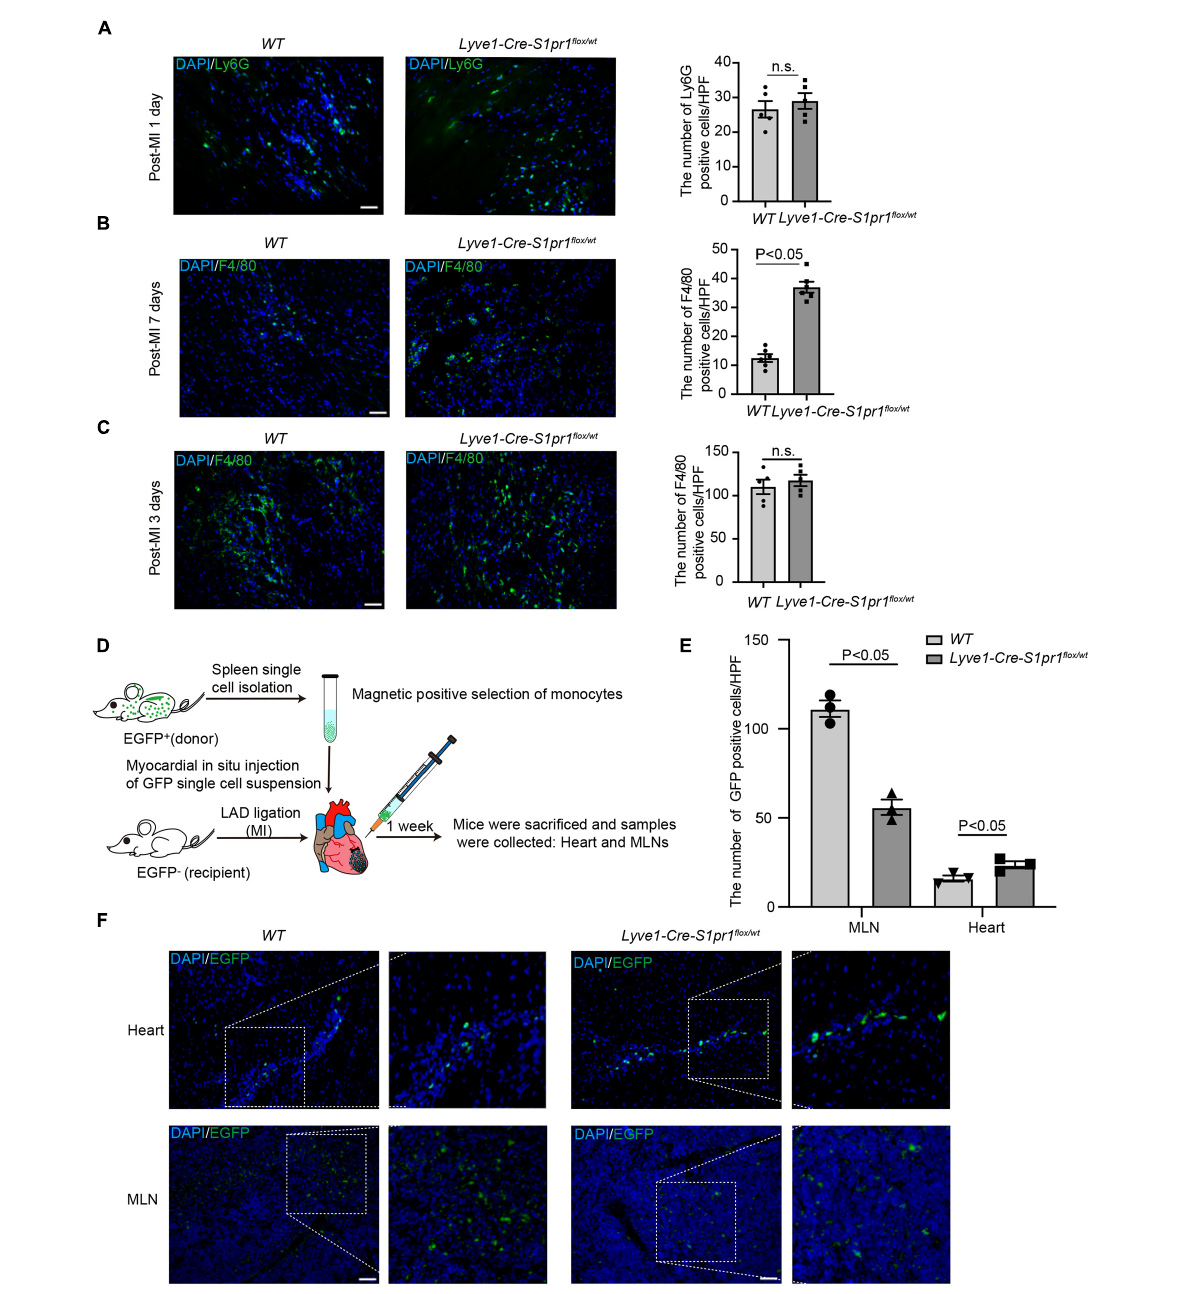
FIGURE5 The reduced expression of LEC-S1pr1 retards macrophage clearance in injured hearts. ( A ) Representative images of immunostaining of Ly6G (neutrophil marker) from hearts in WT and Lyve1-Cre-S1pr1 flox / wt at 1 day after MI, with quantification of the number of neutrophils in infarct zone of myocardium of the indicated groups ( n = 5). (B) Representative images of immunostaining of F4/80 (macrophage marker) within infarct zone of hearts in WT and Lyve1-Cre-S1pr1 flox / wt at 7 days after MI, with quantification of the number of macrophages in myocardium of the indicated groups ( n = 6). (C) Representative images of immunostaining of F4/80 (macrophage marker) from hearts in WT and Lyve1-Cre-S1pr1 flox / wt at 3 days after MI, with quantification of the number of macrophages in infarct zone of myocardium of the indicated groups ( n = 5). (D) Schematic diagram of the adoptive cell transfer approach. EGFP transgenic mice were used as splenic EGFP + monocyte donors, and recipient WT or Lyve1-Cre-S1pr1 flox / wt adult mice received donor EGFP + monocytes via intramyocardial delivery at the time of LAD ligation and EGFP donor monocyte trafficking was monitored in post-MI hearts and their draining MLNs ( n = 3). (E,F) Representative fluorescence images of hearts and draining MLNs in WT and Lyve1-Cre-S1pr1 flox / wt at 7 days after MI, with quantification of the number of EGFP + macrophages in the myocardium of the indicated groups. Less donor GFP + macrophages were detected in draining MLNs of Lyve1-Cre-S1pr1 flox / wt mice compared with WT mice, while more donor EGFP + macrophages in hearts of Lyve1-Cre-S1pr1 flox / wt mice ( n = 3). Scale bars for (A–C,F) , 50 µ m. Data are mean ± S.E.M. n.s., no statistical